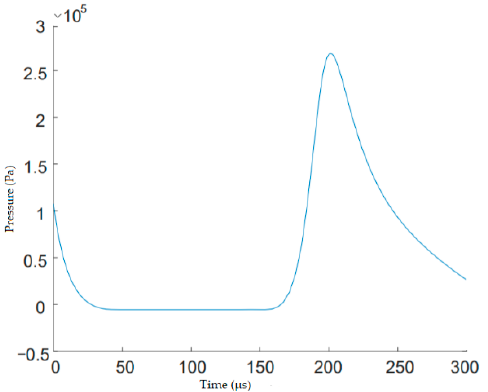
Figure 10. Pressure induced to bubbles over time.